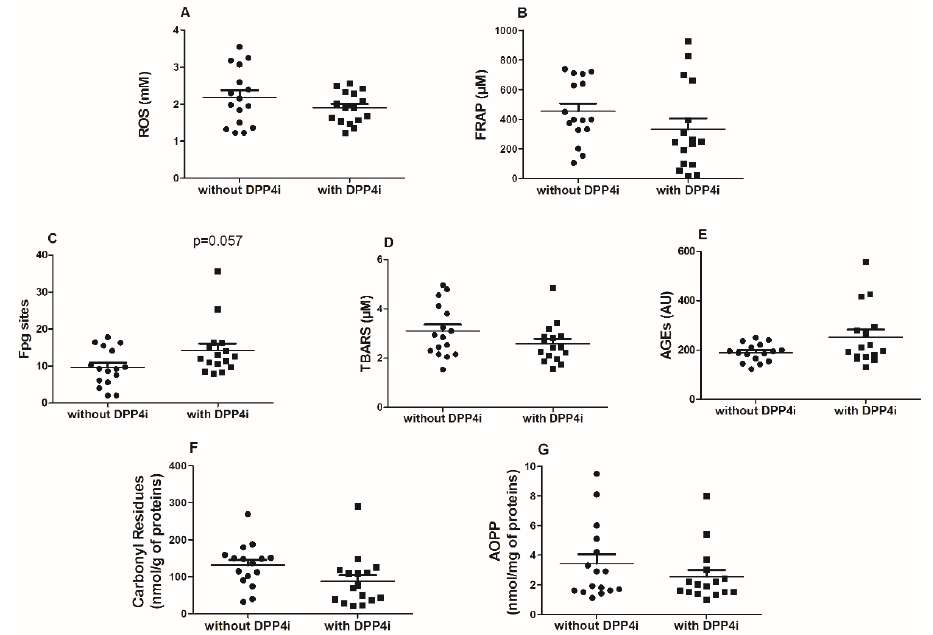
Figure 1. Scatter dot plot of reactive oxygen species (ROS) (panel A ), ferric reducing ability of plasma